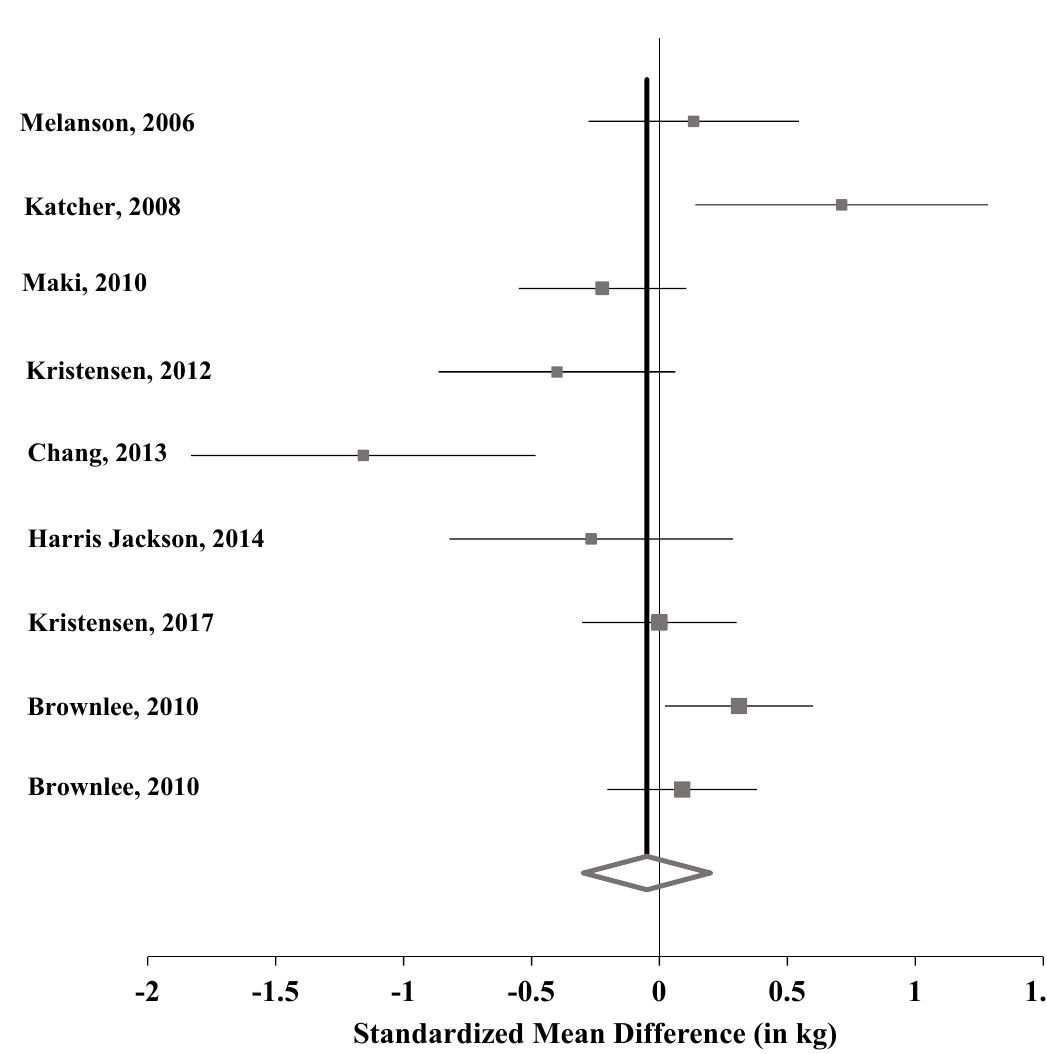
Figure 4. Synthesis forest plot of included studies (values to the left of the line indicate net weight loss for the whole grain